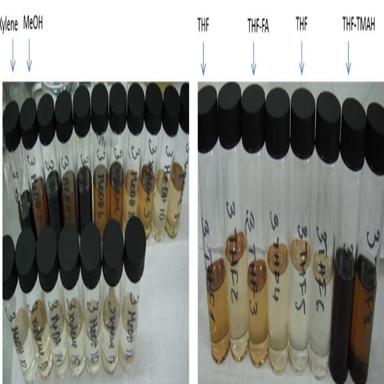
Appearance of organic layer extracts of sandstone reservoir core plug B.